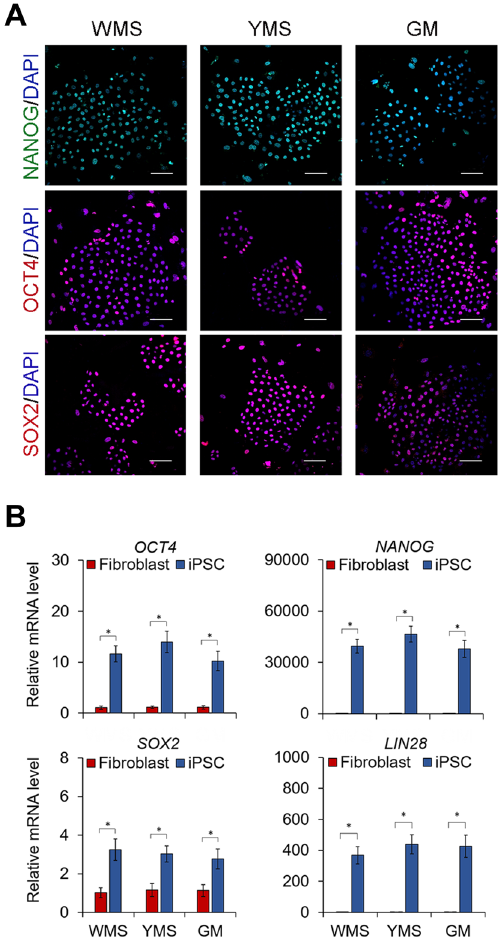
Figure 2. Expression of pluripotency markers in pig iPSCs and parental fibroblasts. ( A ) Immunofluorescence staining detecting the expression of the pluripotency markers NANOG, OCT4, and SOX2 in iPSC lines generated from WMS, YMS, and GM fibroblasts. DAPI stains nuclei (blue). ( B ) Relative mRNA levels of the pluripotency markers NANOG, OCT4, SOX2, and LIN28 determined by quantitative RT–PCR. Scale bar = 100 µm. * p < 0.05; n =